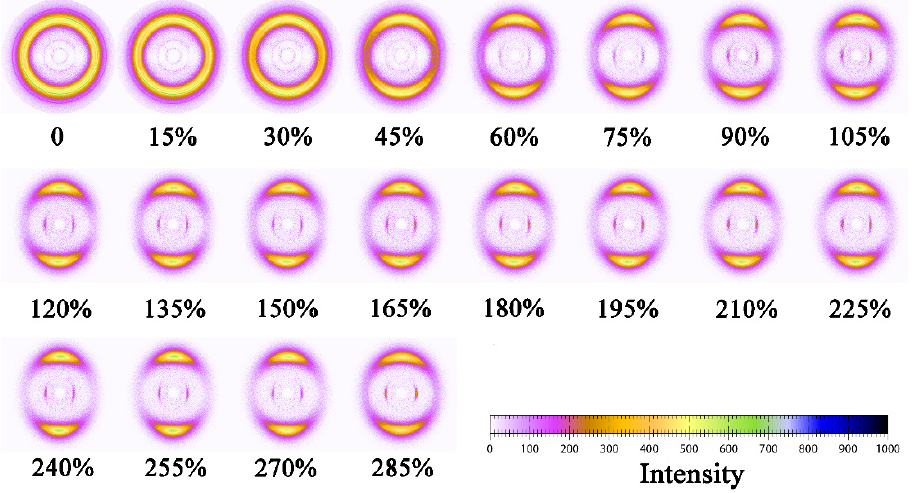
Figure 7. 2D WAXD patterns of PAPACM12 under stretching with strain marked. Notes: stretching was performed along the horizontal direction.